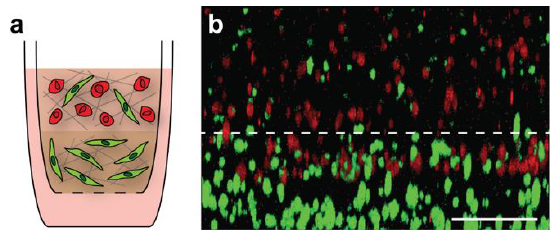
Figure 6. Layering of primary tumor and primary stroma models . Schematic of multi-layered breast cancer model ( a ). MDA-MB-231 breast cancer cells were labeled with CellTracker Deep Red and fibroblasts were labeled with CellTracker Green prior to use. A three-dimensional image was obtained of the boundary between the top tumor model and bottom stroma model 18 h after gel formation ( b ). Gel orientation remained intact after fixation and removal from the tissue-culture insert. Breast cancer cell invasion from the tumor layer into the stroma layer can be seen, indicating that cells were able to migrate through the gel boundary. Scale bar = 200 μm .